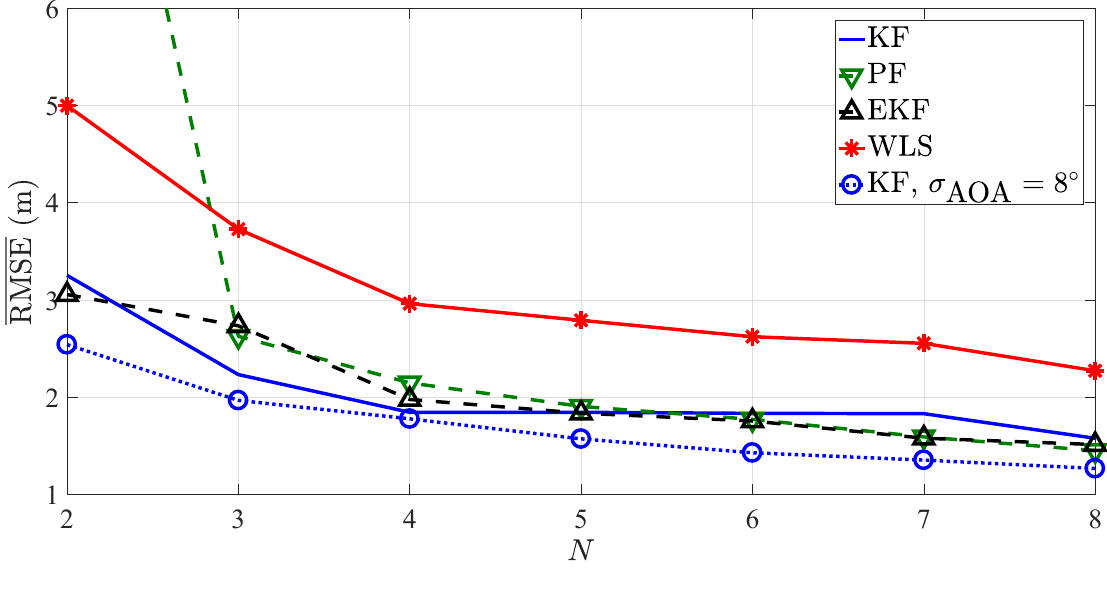
Figure 6. RMSE versus N , when |L NLOS | = N , σ i = 3 (dB, m), bias max = 5 (dB, m), bias i ∼ U [ 0,bias max ] , B = 30